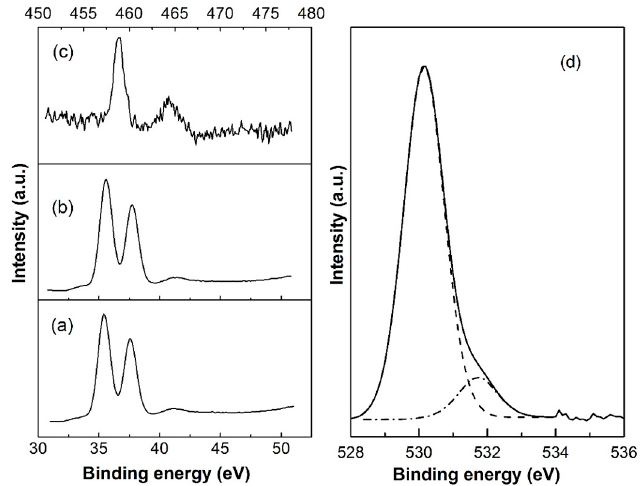
Figure 3. XPS spectra of ( a ) W 4f of TO2, ( b ) W 4f of TTO2, ( c ) Ti 2p of TTO2, and ( d ) O1s-level of TTO2.